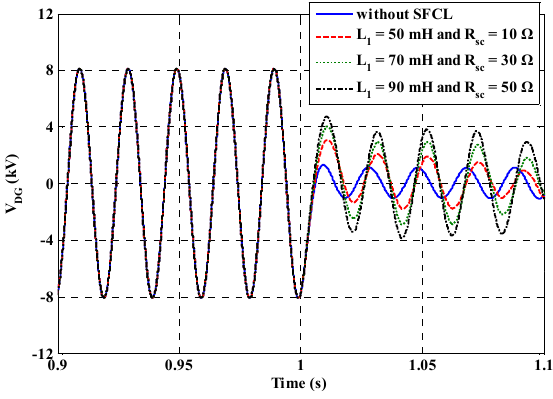
Figure 16. Voltage at the integration point of the DG units under the internal fault (A ‐ phase).